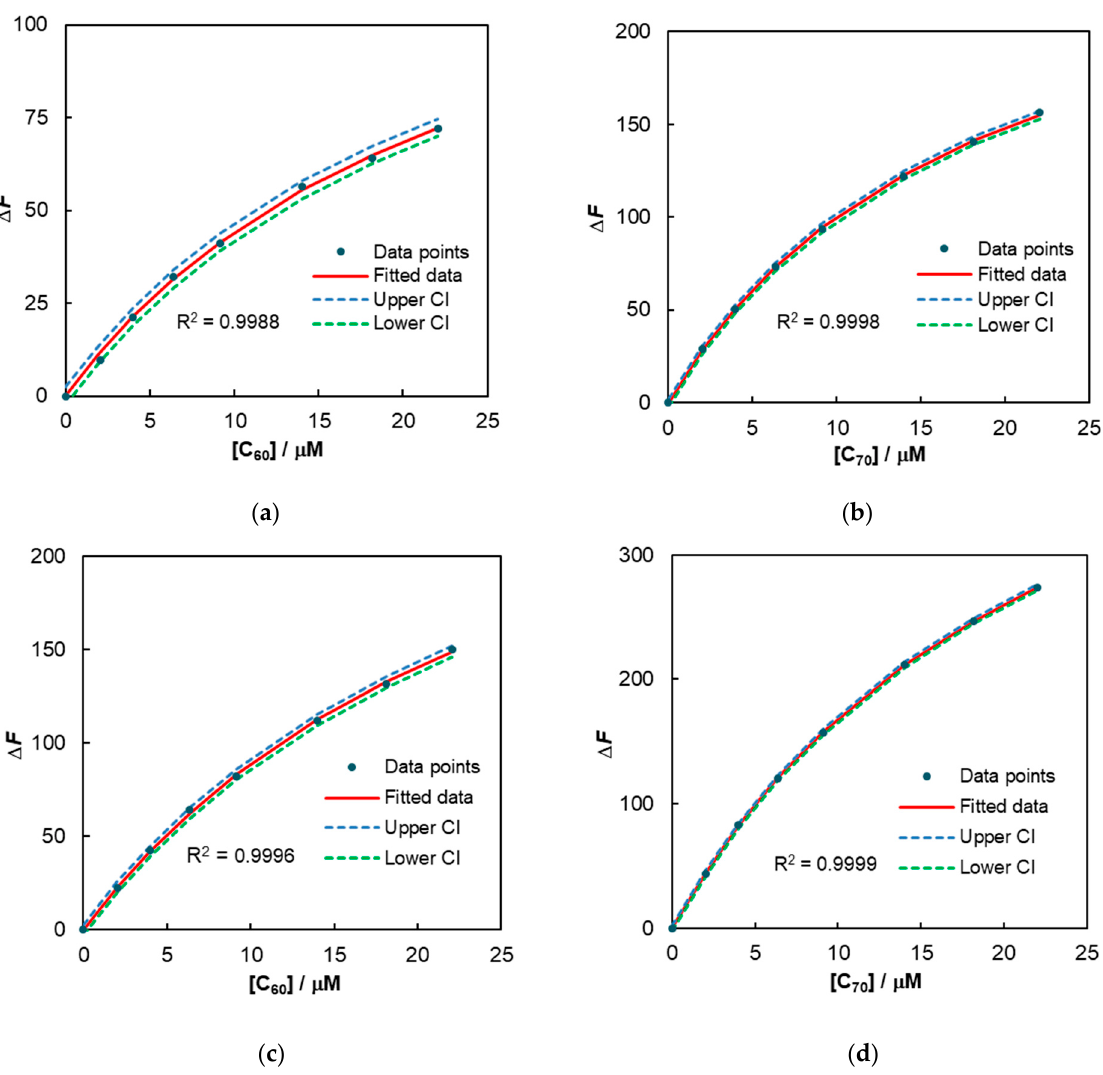
C 70 ( b ) ( λ exc = 340 nm).